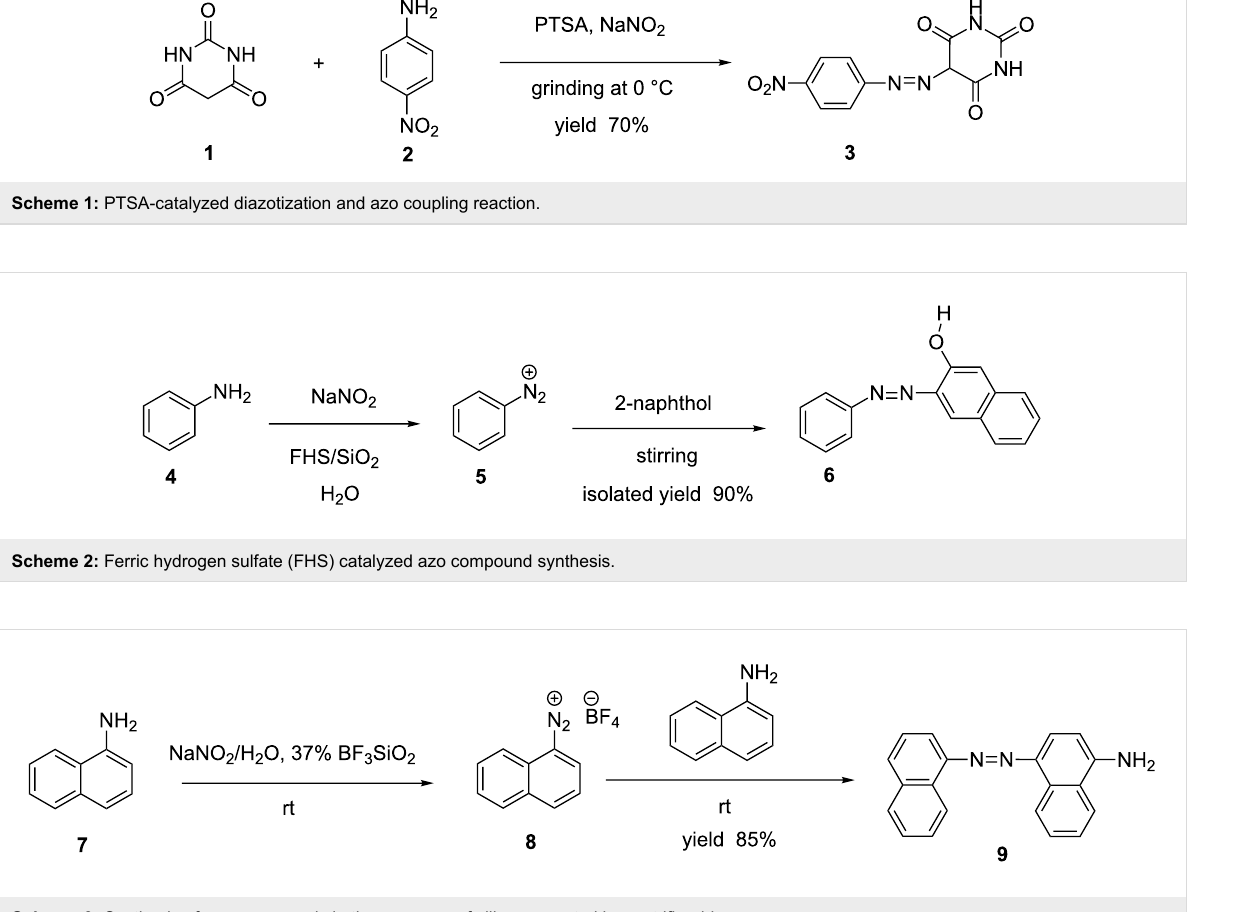
Scheme 3: Synthesis of azo compounds in the presence of silica supported boron